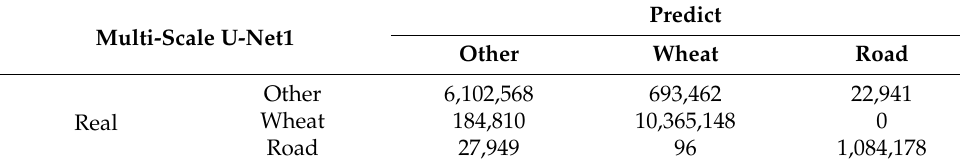
Table 6. Multi-Scale U-Net1 Confusion Matrix.